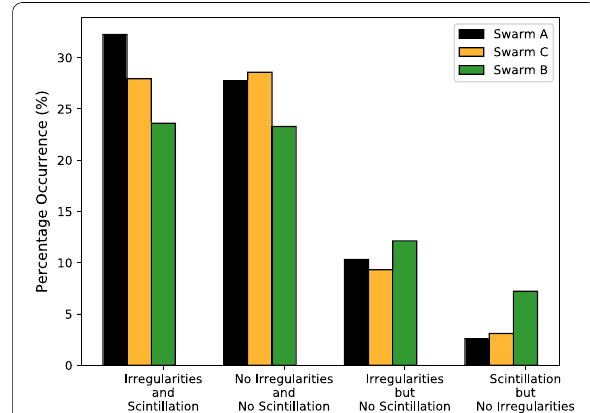
Fig. 5 Percentage occurrence of N e irregularities in each category observed by the Swarm satellites in relation to scintillation events recorded by the GPS-SCINDA installed in Mbarara for the